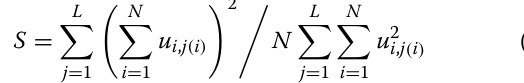
activity. The eruption sequence was recorded on a sub- set of seismic stations that were also utilized for a VLP swarm occurring in August 2011 (Jolly et al. 2017). From Kawakatsu et al. (2000), coherency among seismograms can be characterized using: